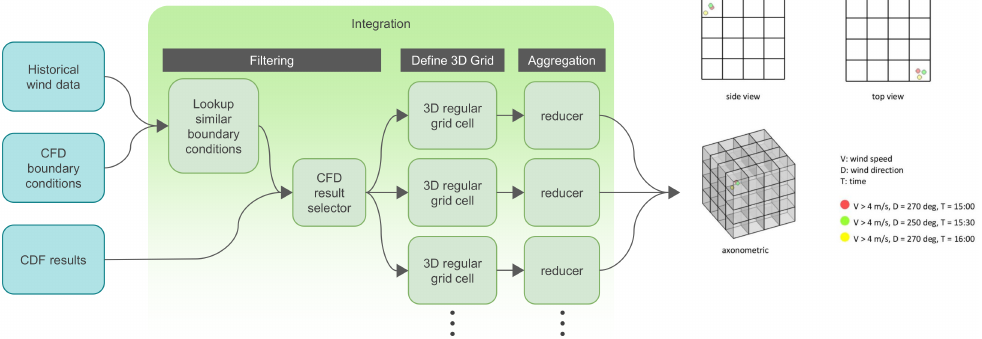
Figure 5. The integration of historical wind data and CFD wind fields will generate a three- dimensional grid. Each grid cell will enclose useful spatial, attributive, and temporal information for decision-making